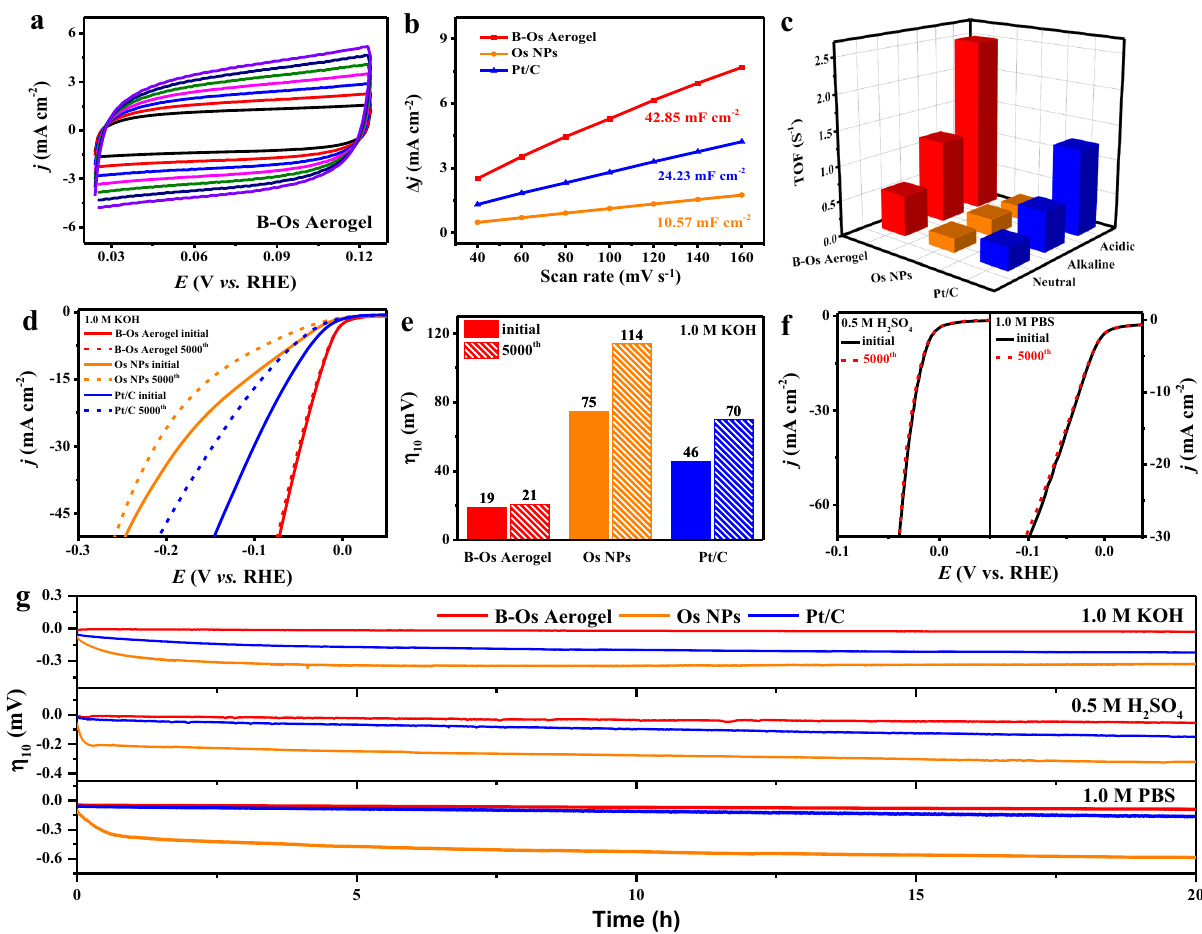
Fig. 3 Comparison of electrochemical HER parameters. a , b Cyclic voltammetry (CV) plots of B-Os aerogels with varying scan rates from 40 to 160mVs − 1 and C dl measurement of B-Os aerogels, Os NPs and Pt/C in 1.0 M KOH solution. c TOF values of B-Os aerogels, Os NPs and Pt/C in 1.0M KOH, 0.5M H 2 SO 4 and 1.0M PBS solutions, respectively. d , e iR-corrected polarization curves and corresponding overpotential changes at 10mAcm − 2 of B-Os aerogels, Os NPs and Pt/C were recorded before and after 5000 CV potential cycles in 1.0M KOH solution. f iR-corrected polarization curves of B-Os aerogels were recorded before and after 5000 CV potential cycles in 0.5 M H 2 SO 4 and 1.0M PBS solutions, respectively. g The chronopotentiometry of B-Os aerogels, Os NPs and Pt/C in 1.0 M KOH, 0.5 M H 2 SO 4 and 1.0 M PBS solutions,